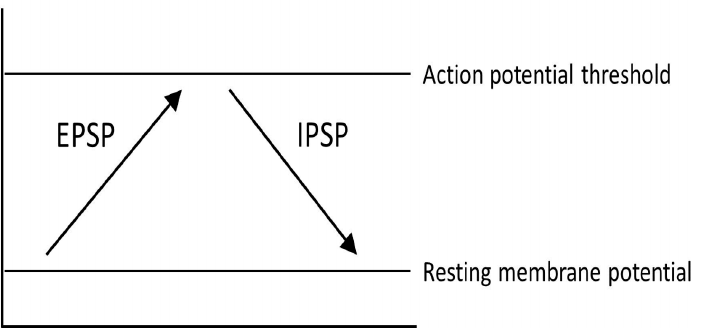
Figure 4. Different physical reactions as a result of excitatory postsynaptic potentials (EPSP) and inhibitory postsynaptic potentials (IPSP)